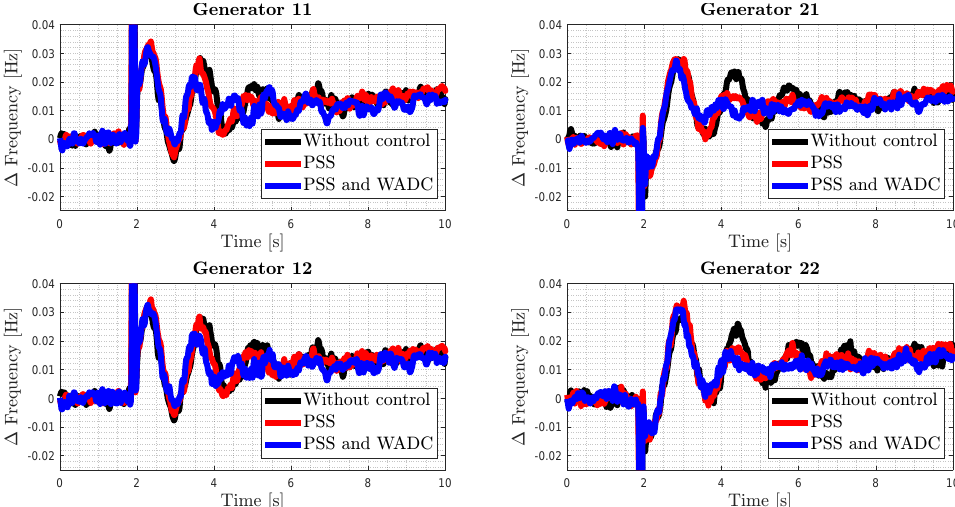
Figure 17. Frequency deviation with respect to the pre-fault value for the three cases (without control, PSS only, PSS and WADC) after the tie line trip within the setup with the dynamic hardware